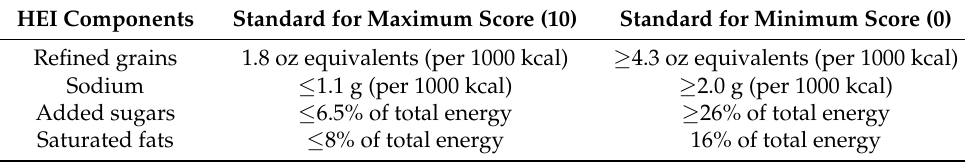
Table 2. Moderation intake HEI components and standards for maximum and minimum